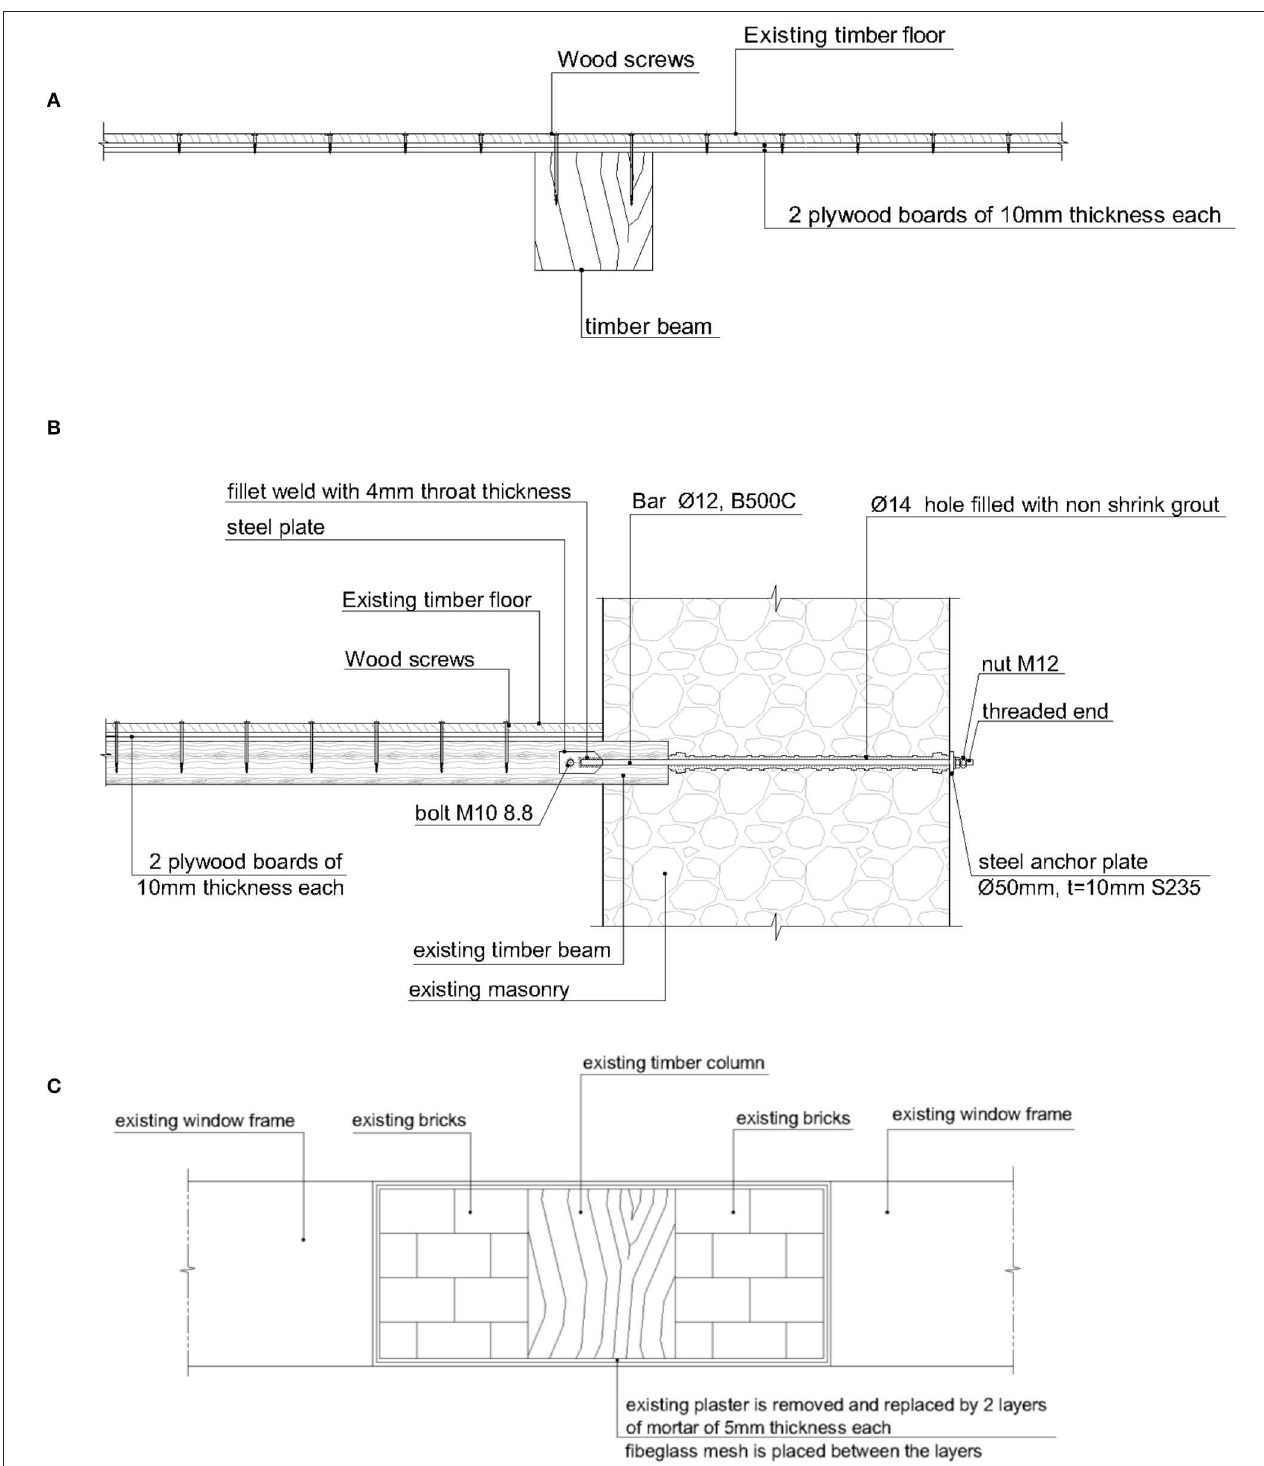
FIGURE 11 | (A) Connection of rigid diaphragms to timber beams, (B) connection of timber beams to unreinforced masonry, and (C) external bonding of masonry infilled timber walls through TRM.